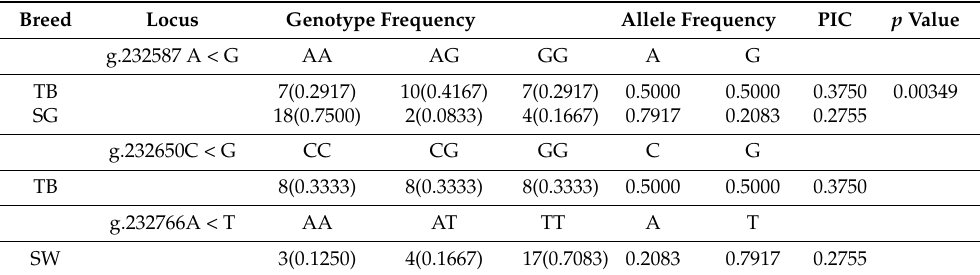
Table 3. Allelic and genotypic distribution of the MITF gene in four rabbit breeds.